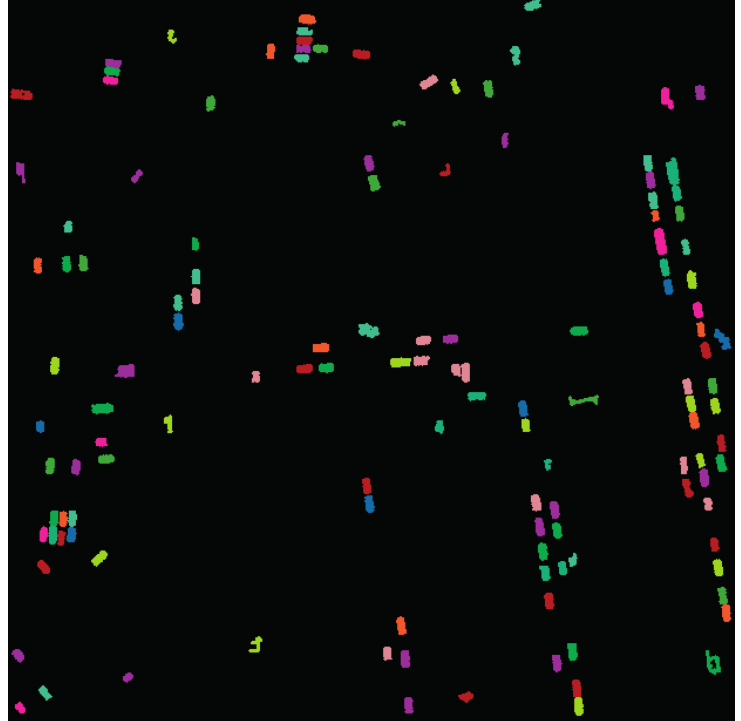
Figure 1a. The data covers an urban area in Enschede, the Netherlands, with a 200-m length and a 200-m width, and it is acquired by a FLI-MAP 400 sensor from John Chance Land Surveys. The FLI-MAP 400 carries a high precision, rotating scanning laser. The scan frequency is up to 250 kHz, and each recording is up to four measurements. The additional element of oblique angle